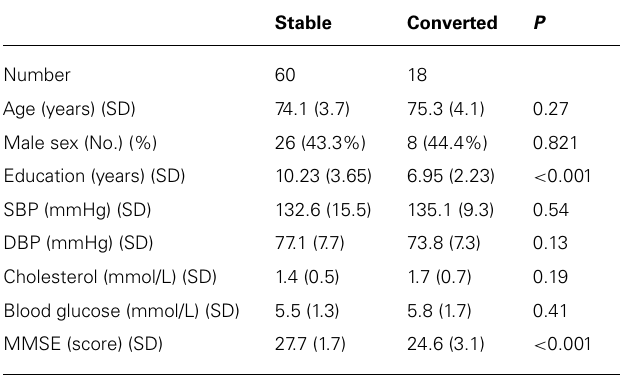
Table 3 | Inverse association between reduction of RNFL thickness in the inferior quadrant and cognitive deterioration in converted participants.